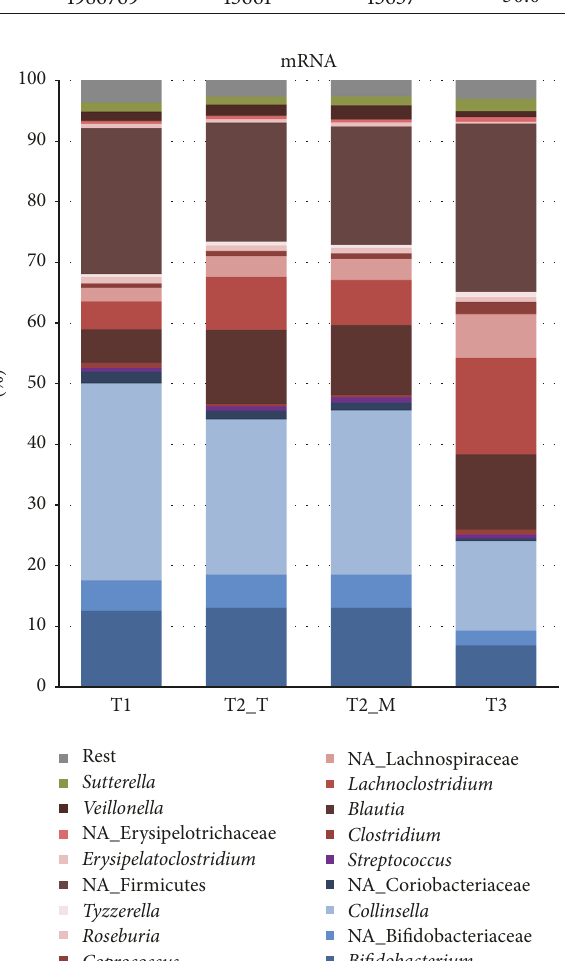
Figure 2: Taxonomic profiles based on